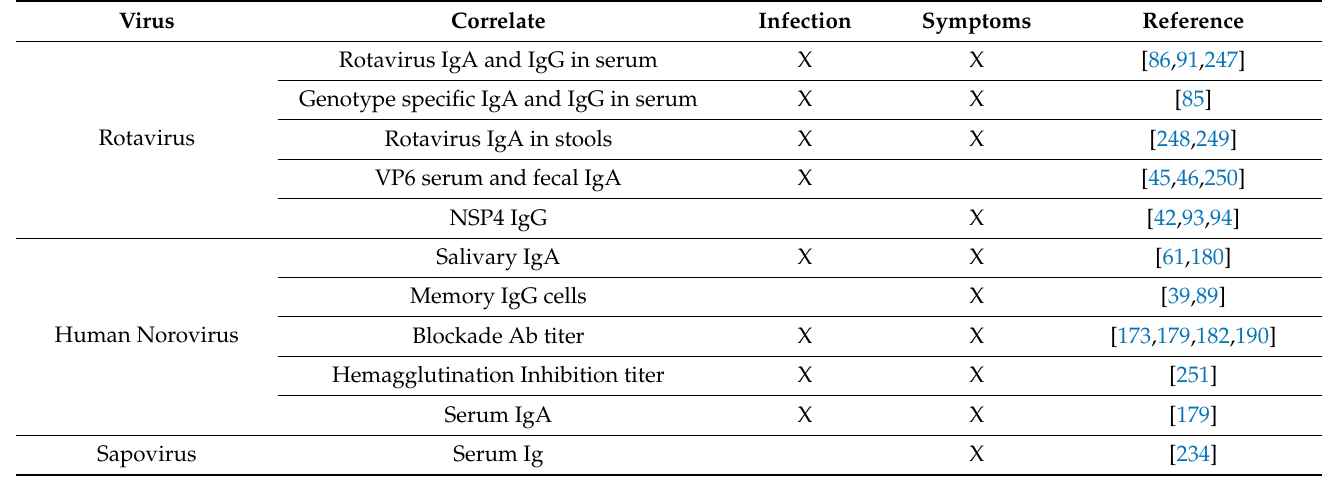
Table 1. Serological Correlates of